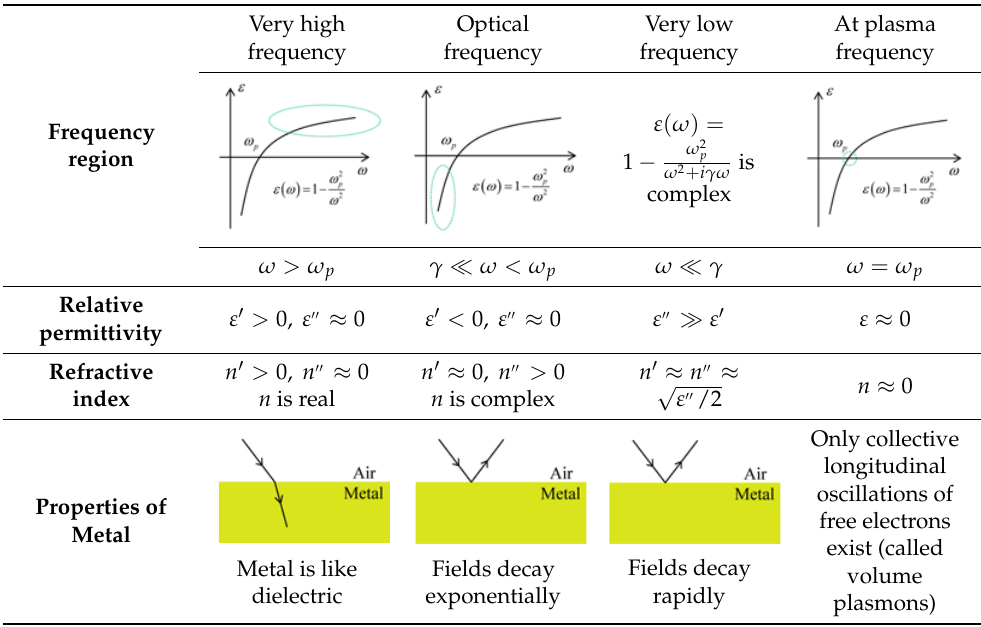
Table 1. The properties of metal for different frequency of